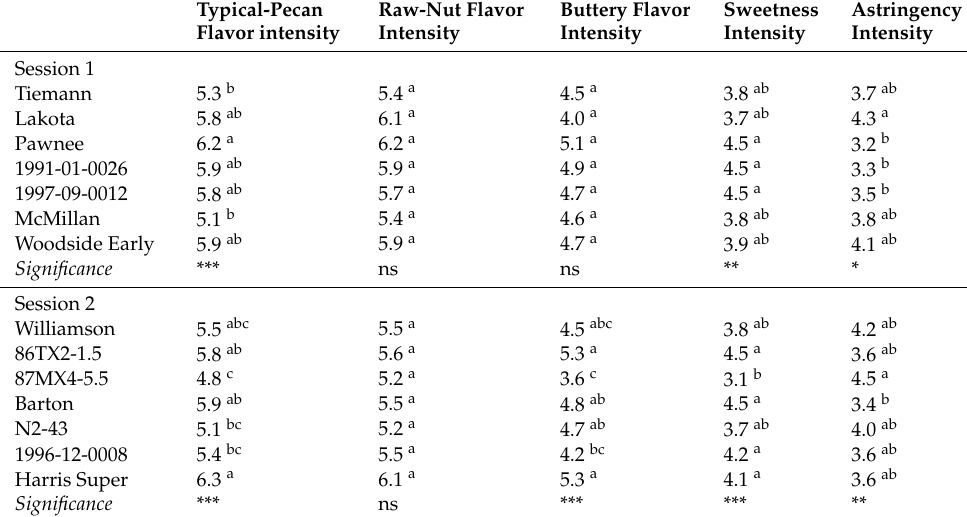
Table 2. Mean scores of five intensity attributes for the consumer tests of 14 pecan varieties.